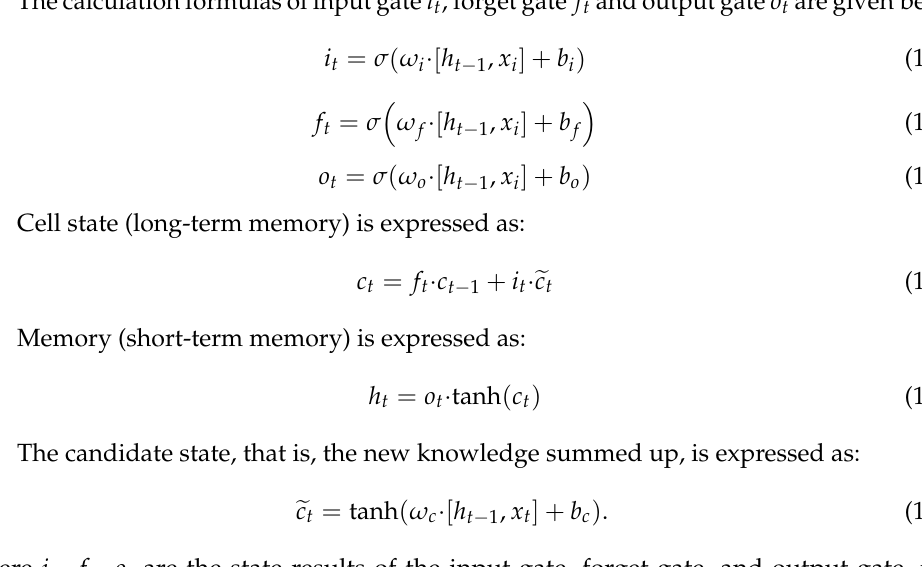
Figure 6. Calculation process of LSTM.